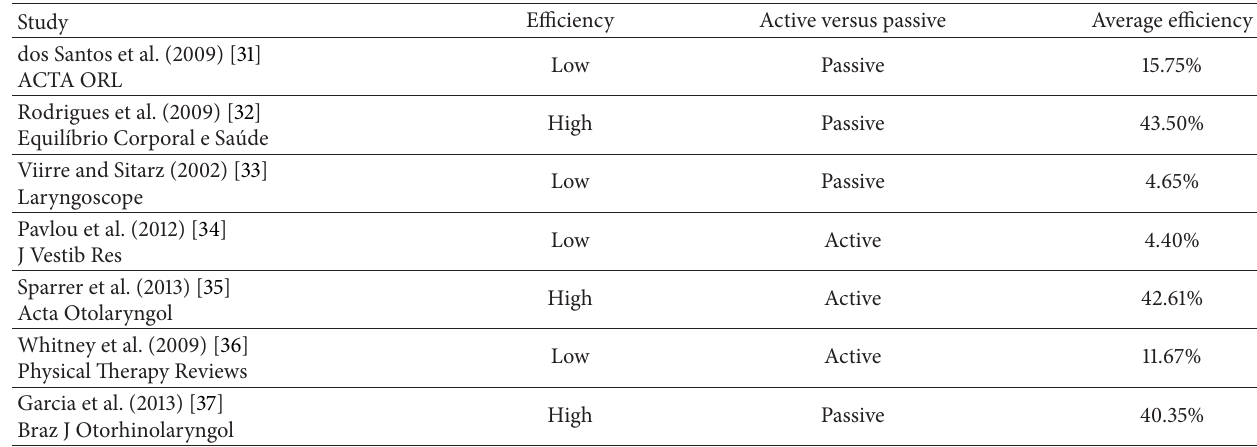
Table 2: Efficiency of rehabilitation regarding the type of